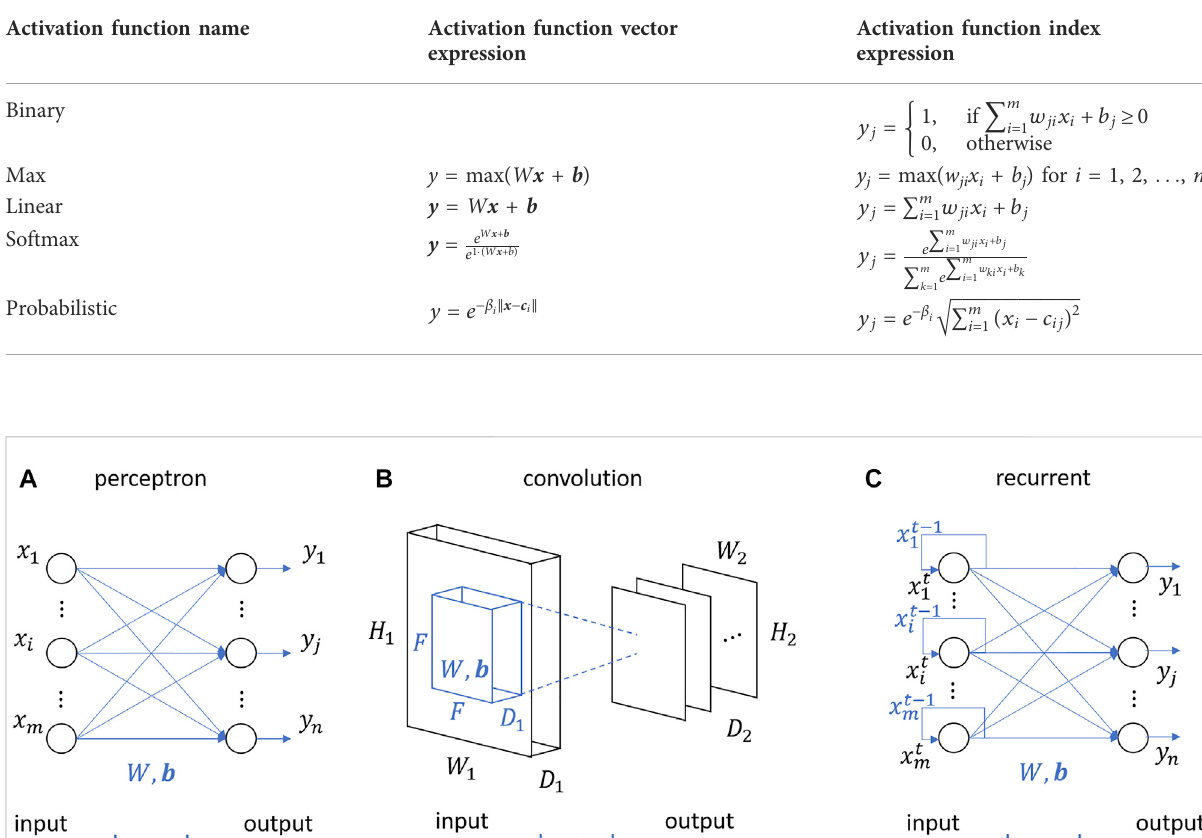
TABLE 1 Activation function type by ascending complexity with their associated vector and index expressions.